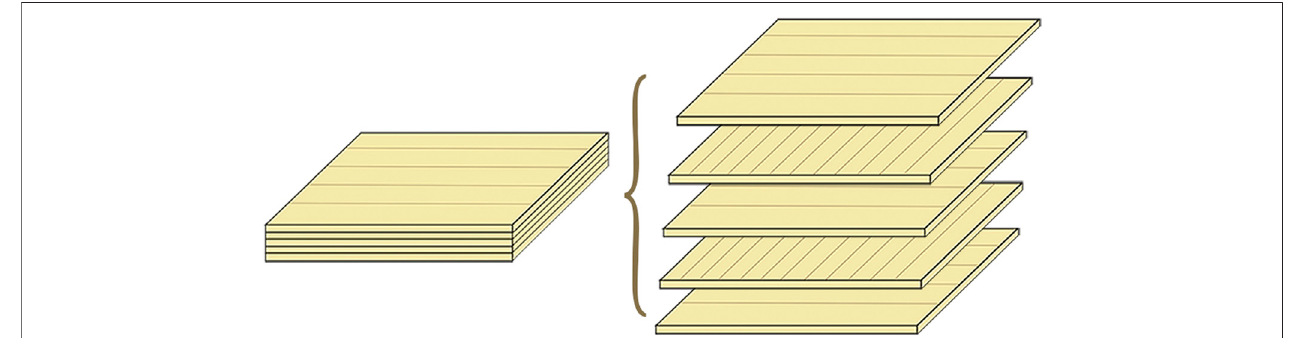
FIGURE 3 | Schematic diagram of 5-layer transparent wood